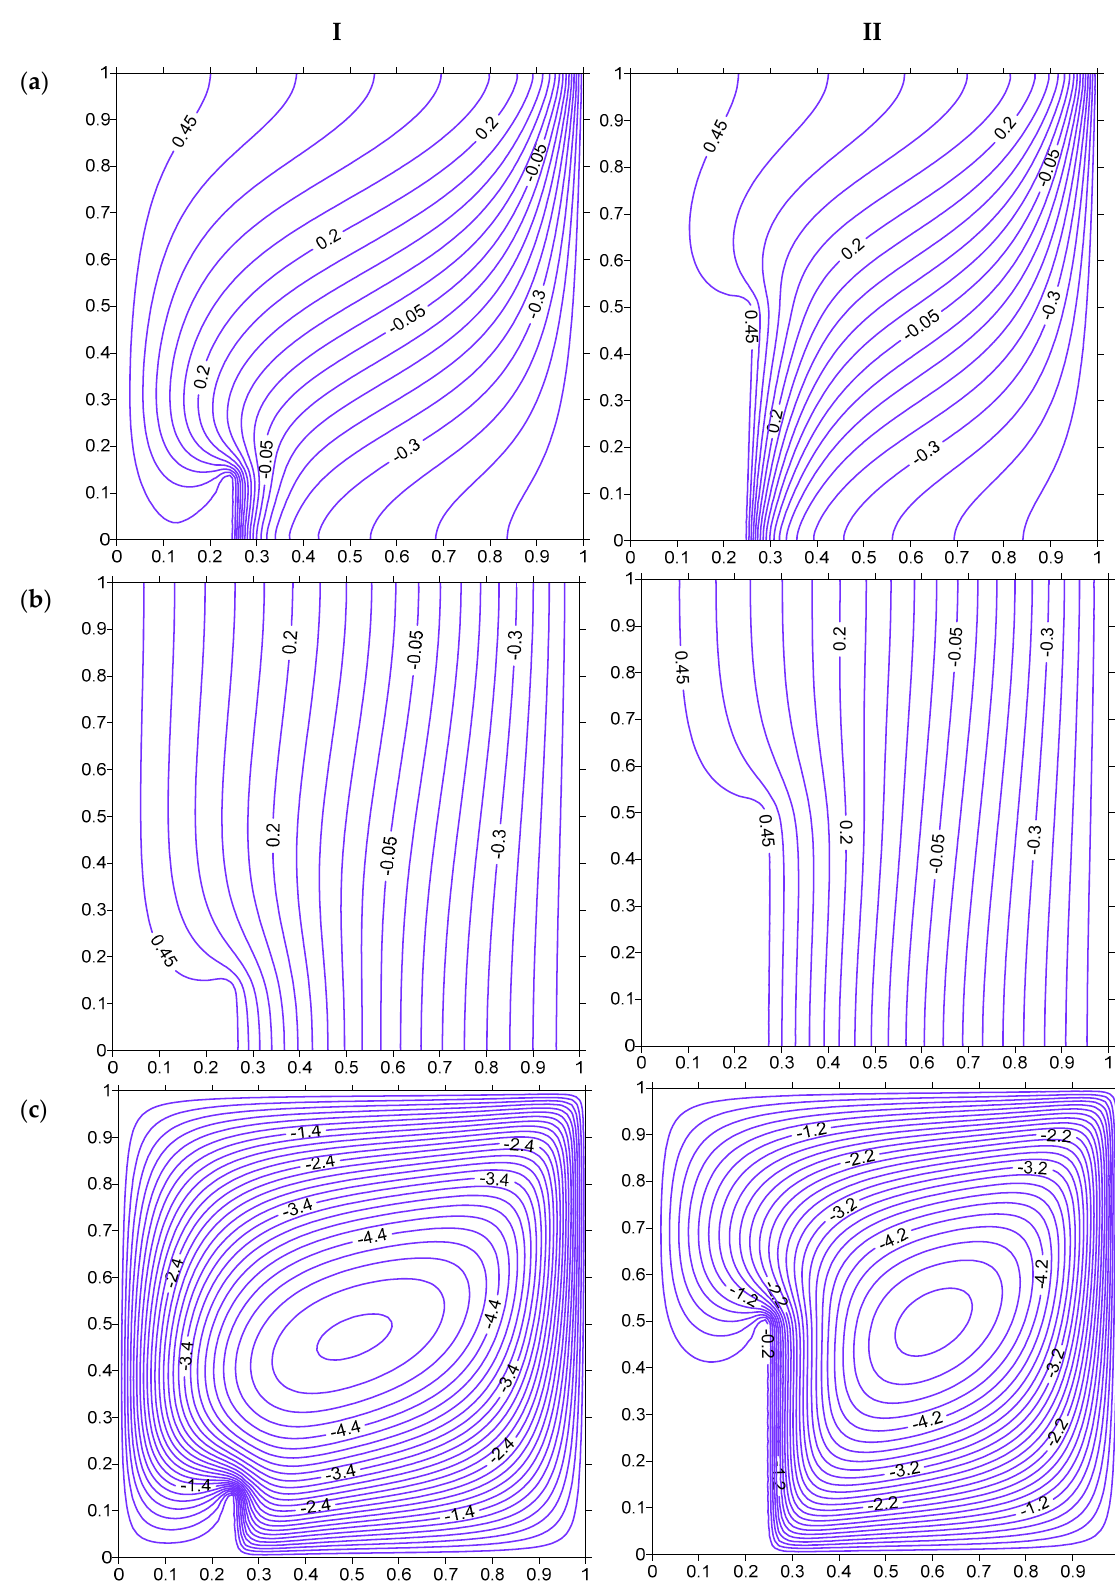
Figure 20. Isotherms (( a ) Fluid, ( b ) Solid), and streamlines ( c ), at Ra = 100 , H = 5 , Kr = 1 , Rd = 0 for strip at x = 0.25. ( I ) HH = 12.5%. ( II ) HH = 50%.